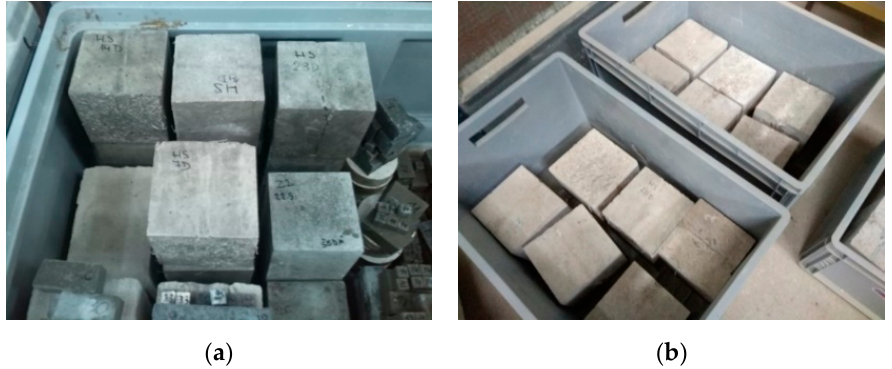
Figure 2. Placement of specimens. ( a ) Specimens in the tank with a humid environment. ( b ) Specimens Figure2. Placementofspecimens. ( a )Specimensinthetankwithahumidenvironment. ( b )Specimensin in tanks with a water level about 20 mm above the bottom. tanks with a water level about 20 mm above the